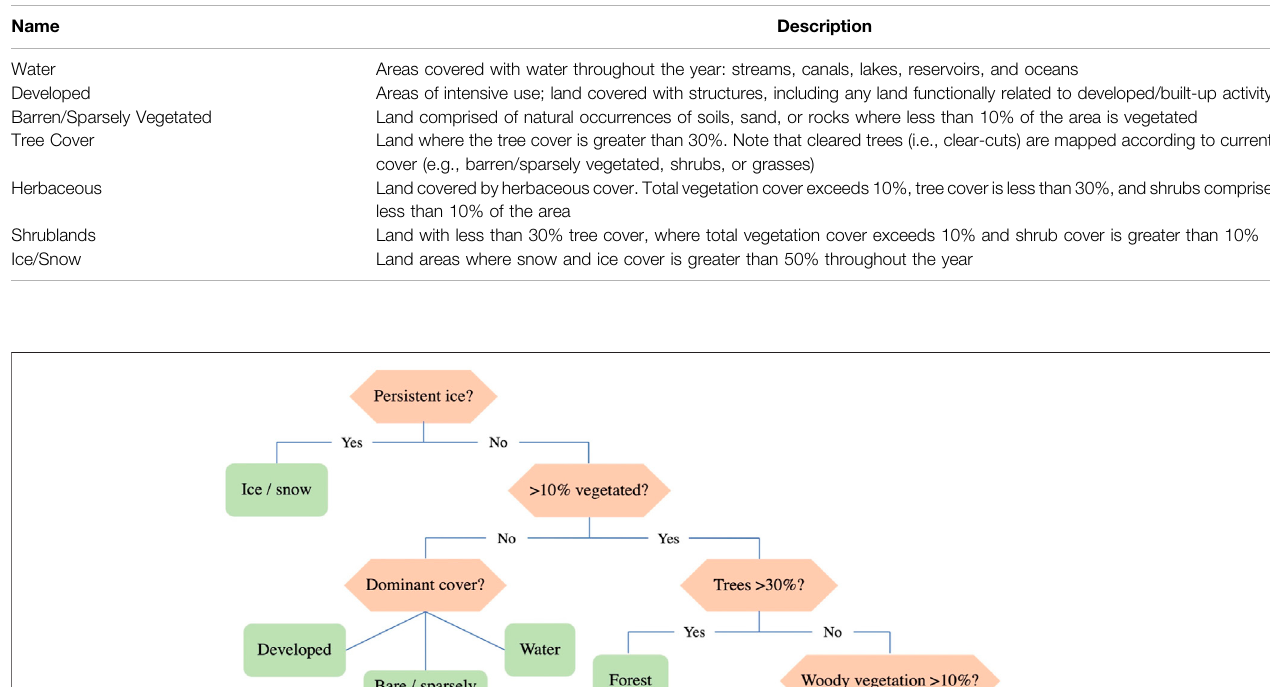
TABLE 1 | Land cover classes included in the GLanCE Level 1 classi fi cation scheme. Note that in addition to these layers, the product includes a variety of complementary information (see Table 3 ).